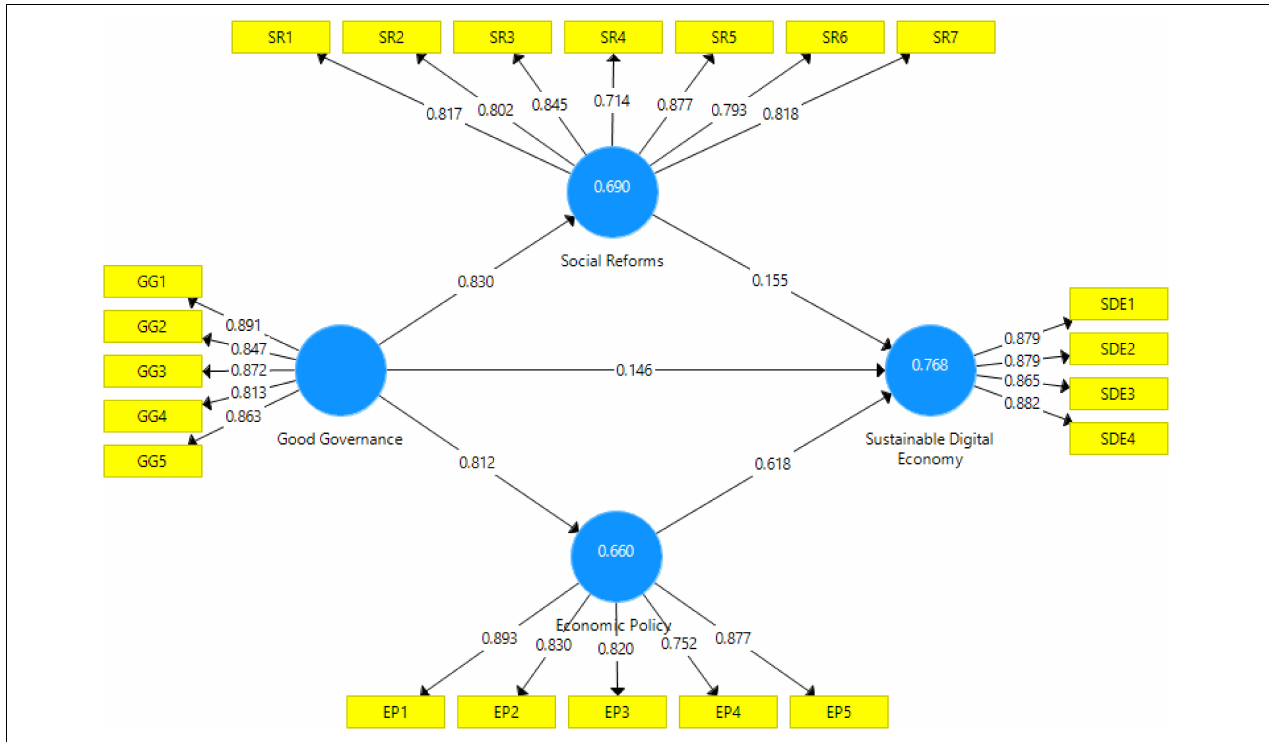
FIGURE 2 | Measurement model outcomes.